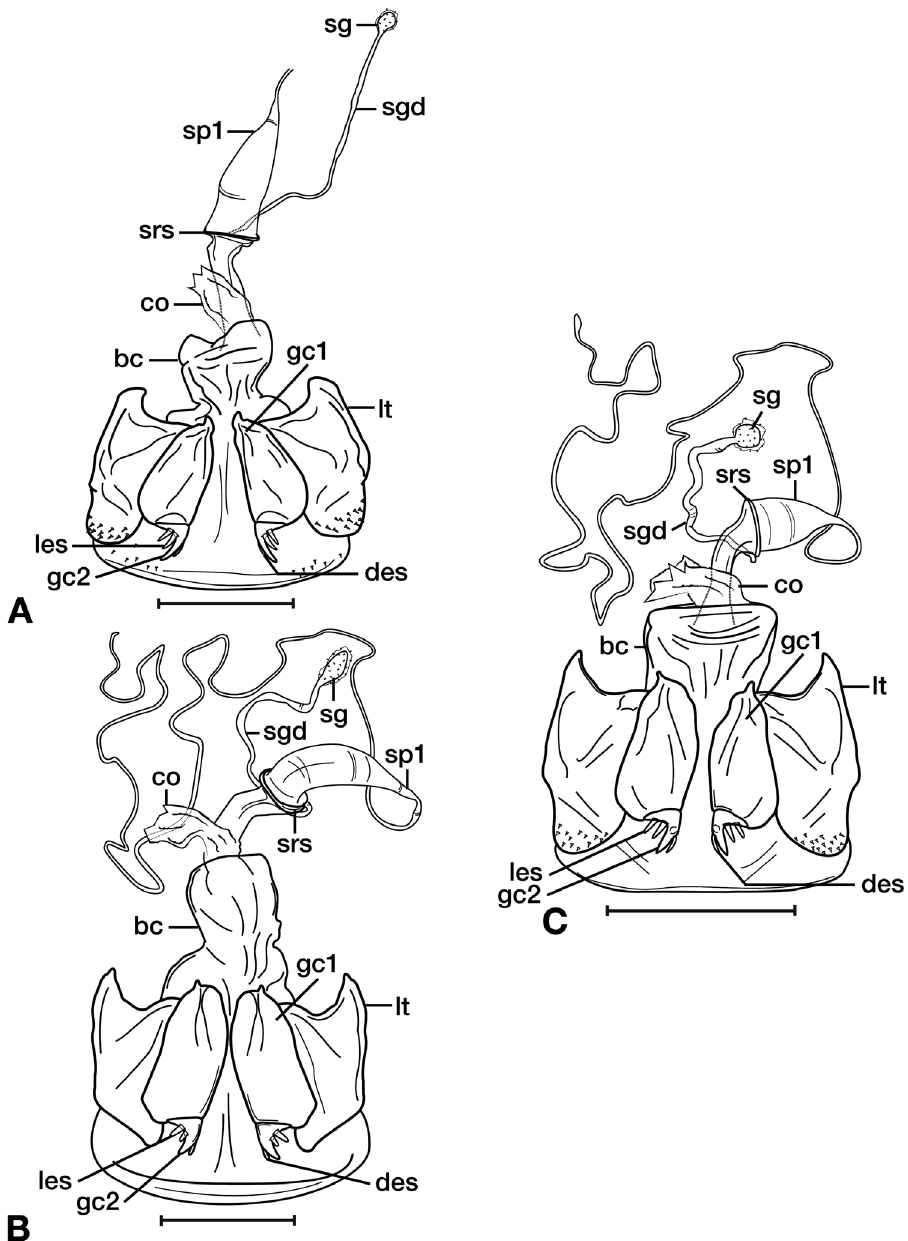
Figure 102. Line drawings of the female reproductive tract of species of the genus Mochtherus Schmidt- Goebel, known from Taiwan, ventral aspect. A M. luctuosus Putzeys B M. obscurabasis sp. n. C M. tetraspi- lotus (MacLeay). Legend: bc bursa copulatrix; co common oviduct; des dorsal ensiform setae; div diver- ticulum; gc1 gonocoxite 1; gc2 gonocoxite 2; les lateral ensiform setae; lt lateral tergite; sg spermathecal gland; sgd spermathecal gland duct; sp1 spermatheca 1; srs spermathecal ring sclerite. Scale bars: 0.5